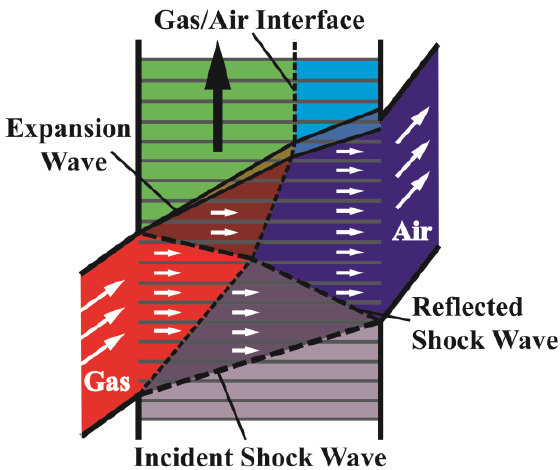
Figure 1. Two-dimensional illustration of high pressure part wave diagram of the wave rotor cycle.